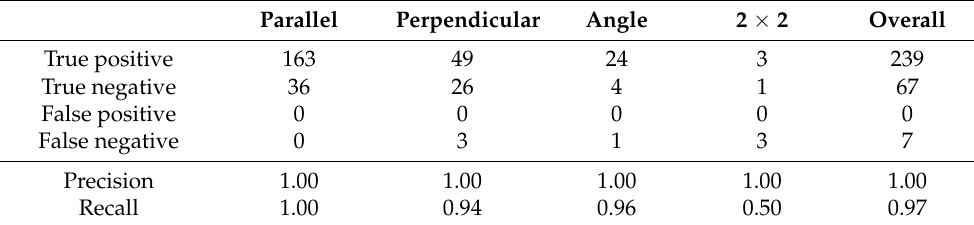
Table 4. AI-based detection results for cars, broken down by type of parking